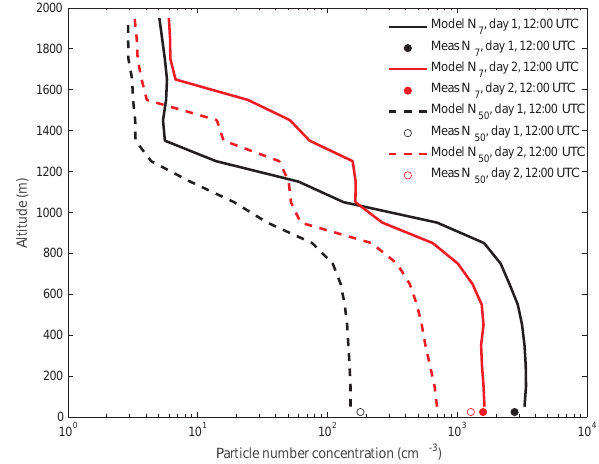
Figure 6. Modeled median vertical profiles of the particle number concentrations of particles larger than > 7nm in diameter ( N 7 ) and > 50nm in diameter ( N 50 ), respectively. Model results are shown both from the first day during the NPF events at 12:00UTC and the second day after the NPF events at 12:00UTC. Shown are also the observed median particle number concentrations at the